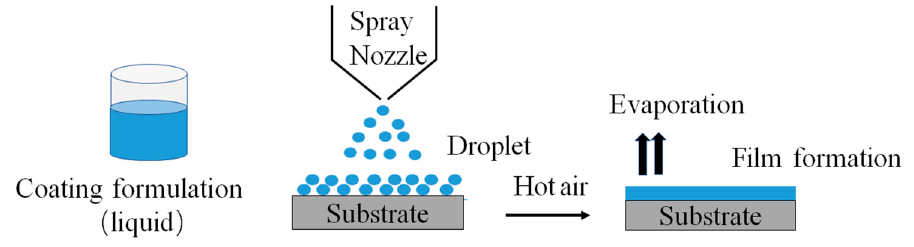
Figure 2. Schematic illustration of the film formation process.